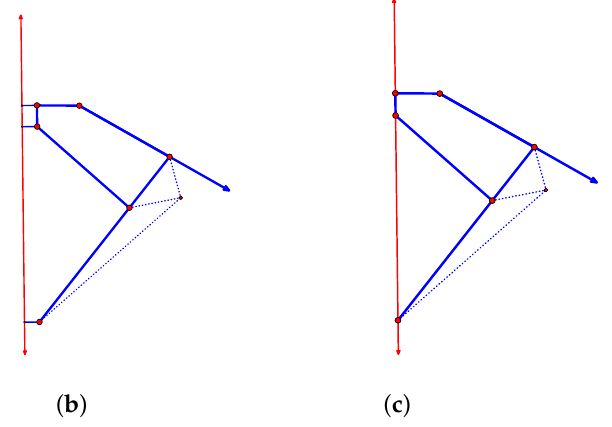
v 6 , v 7 , v 8 have a { }